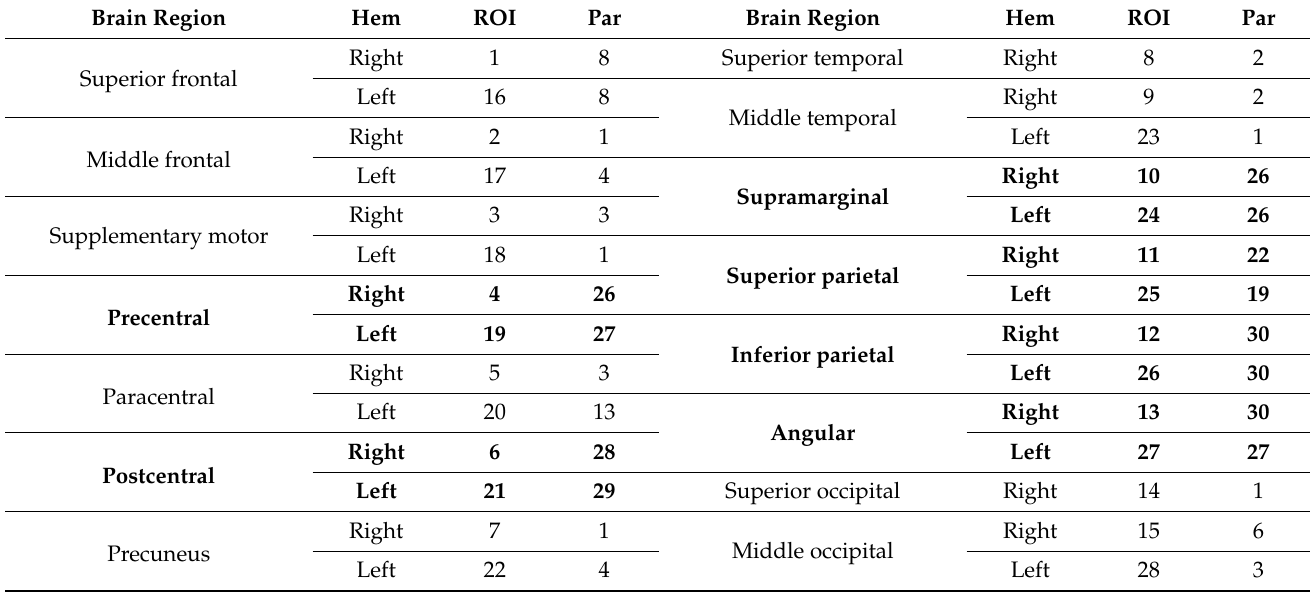
Table 1. Brain regions measured with NIRS. Bold regions: selected regions of interest (ROI); Hem: hemisphere, Par: Number of participants. The numbers in the ROI column are indices of the ROIs.